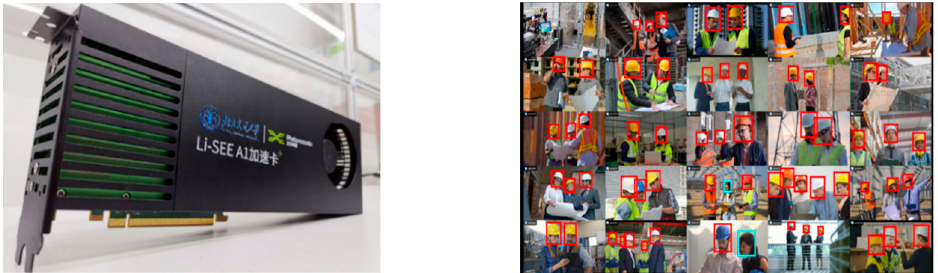
Figure 12. ( a ) Self-developed PAIC. ( b ) Application of this system to complete the data monitoring of the construction